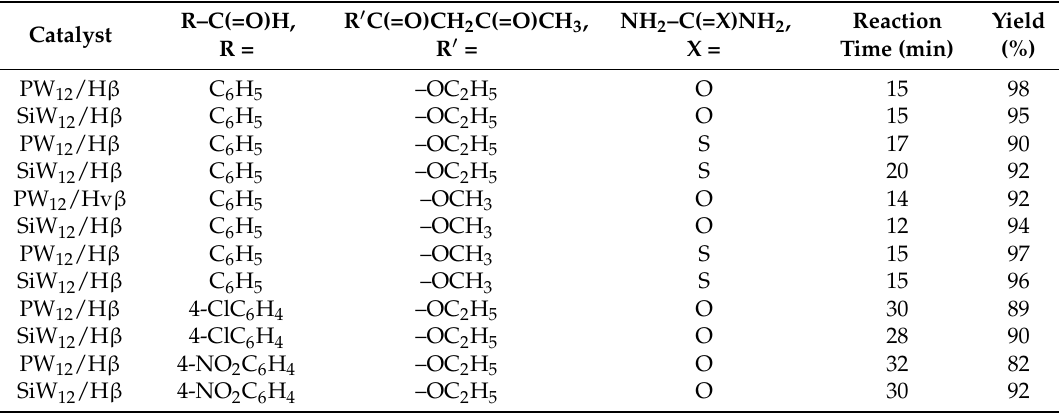
Table 3. Synthesis of various dihydropyrimidones on PW 12 /H β and SiW 12 /H β